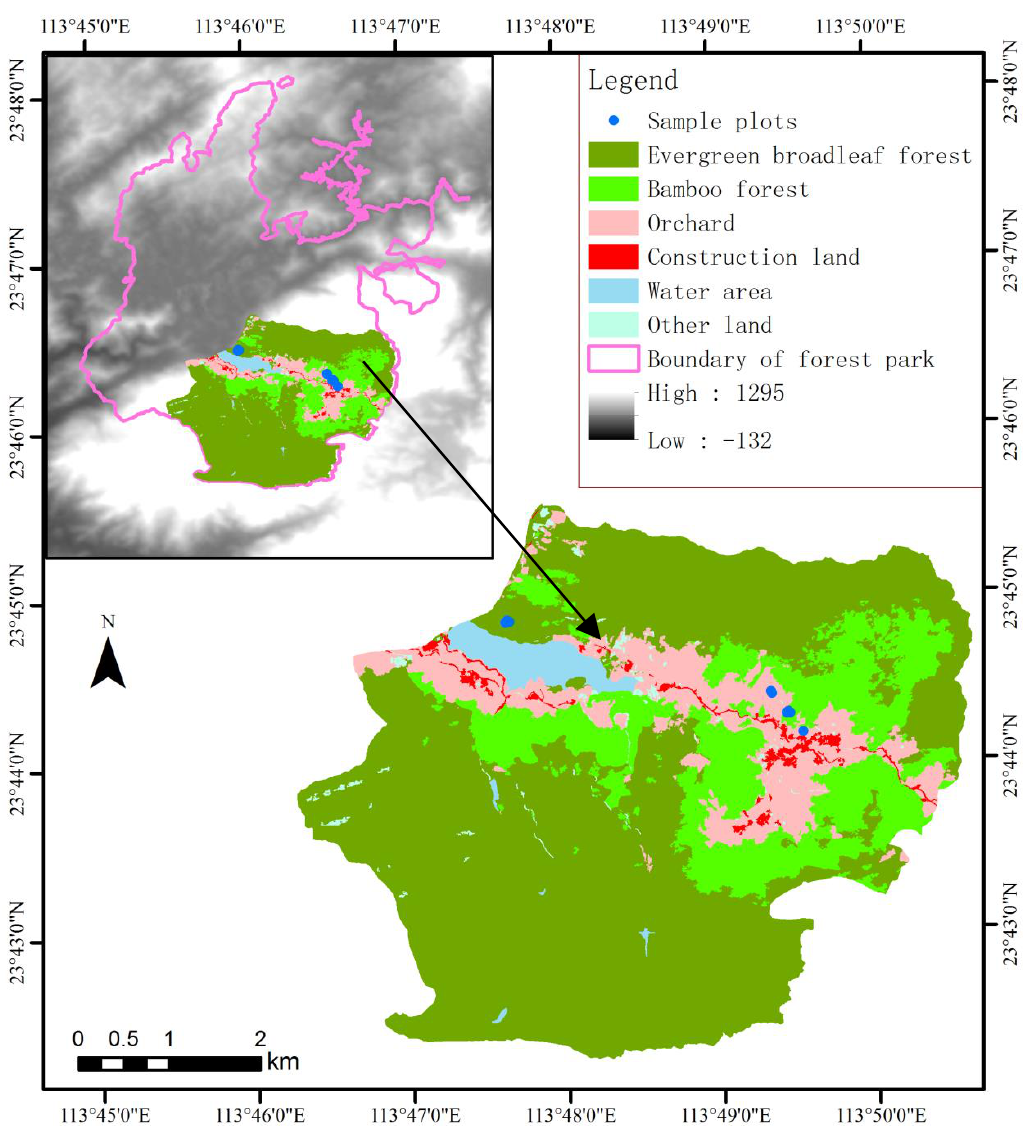
Figure 1. Location of the study site and sampling plots in Liuxihe National Forest Park.